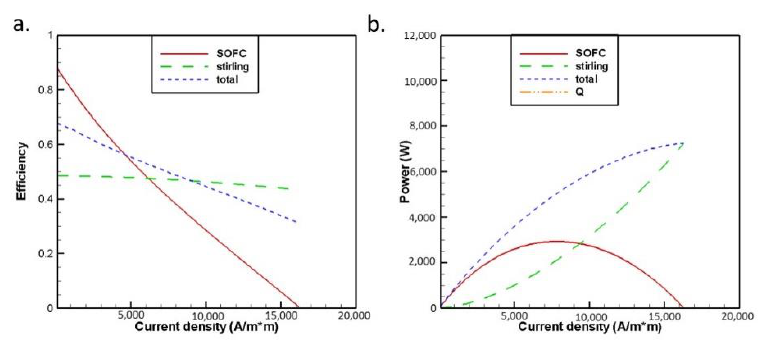
Figure 10. Computed ( a ) efficiency and ( b ) generated power at different current densities at 873 K for the optimized design loop.